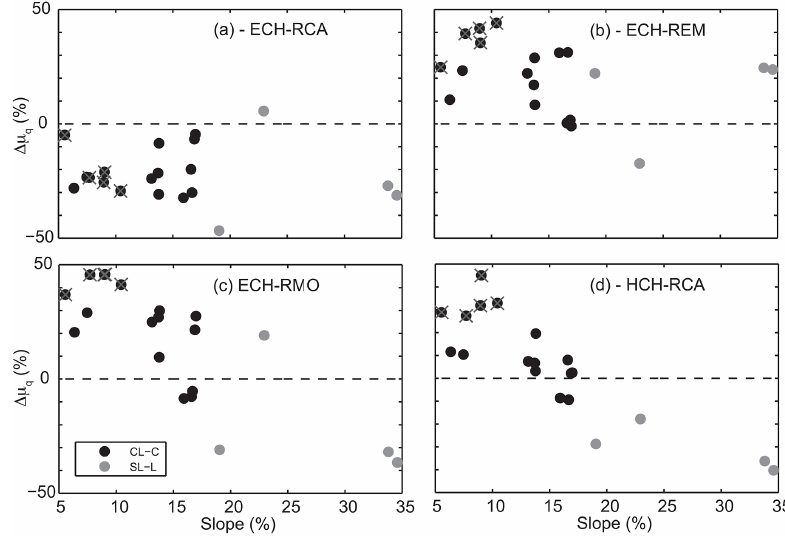
Figure 11. Relation between the change in the mean of the annual maximum Q , (cid:49)µ q , and the corresponding mean slope. Black (gray) circles indicate sub-basins dominated by the clay loam–clay (sandy loam–loam) class; a cross is used to indicate sub-basins 1–4 and 9. Each panel refers to results obtained for each